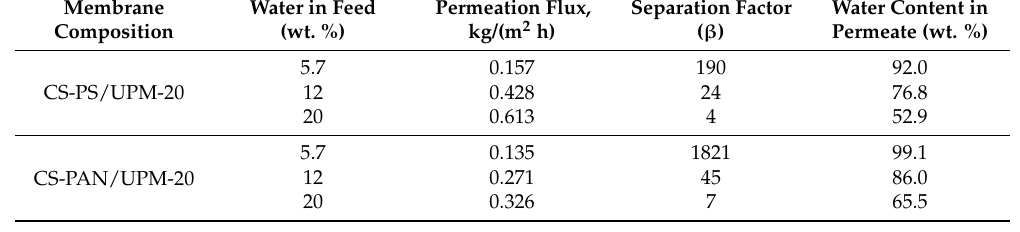
Table 4. Pervaporation results for THF-water mixtures at 295 K.